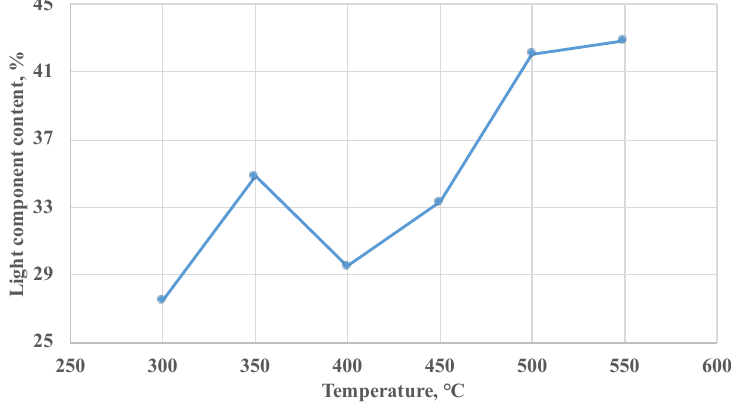
Fig. 5. Relationship between light component content in shale oil and injection